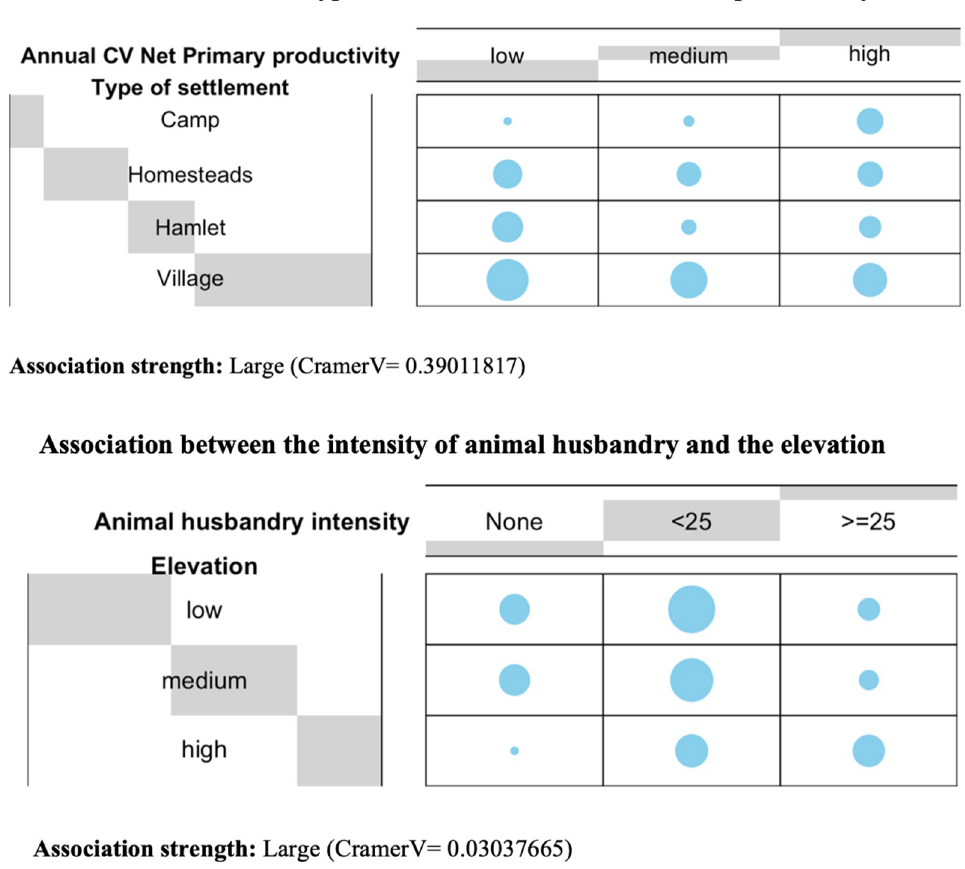
Fig 3. Some examples of binary associations found in the exploratory data